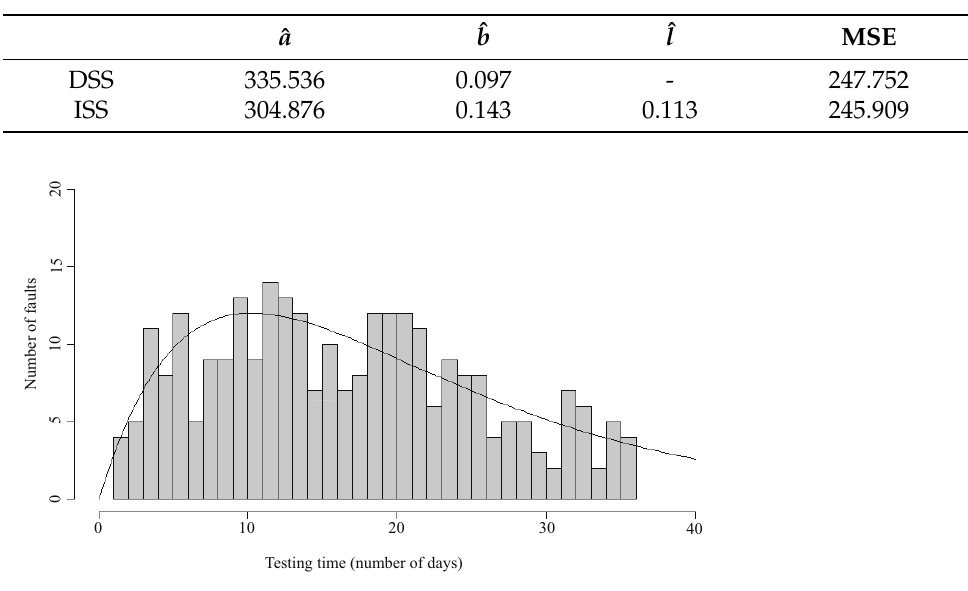
Figure 3. Estimated inflection S-shaped SRGM. Table 1. Estimated parameter and MSE.